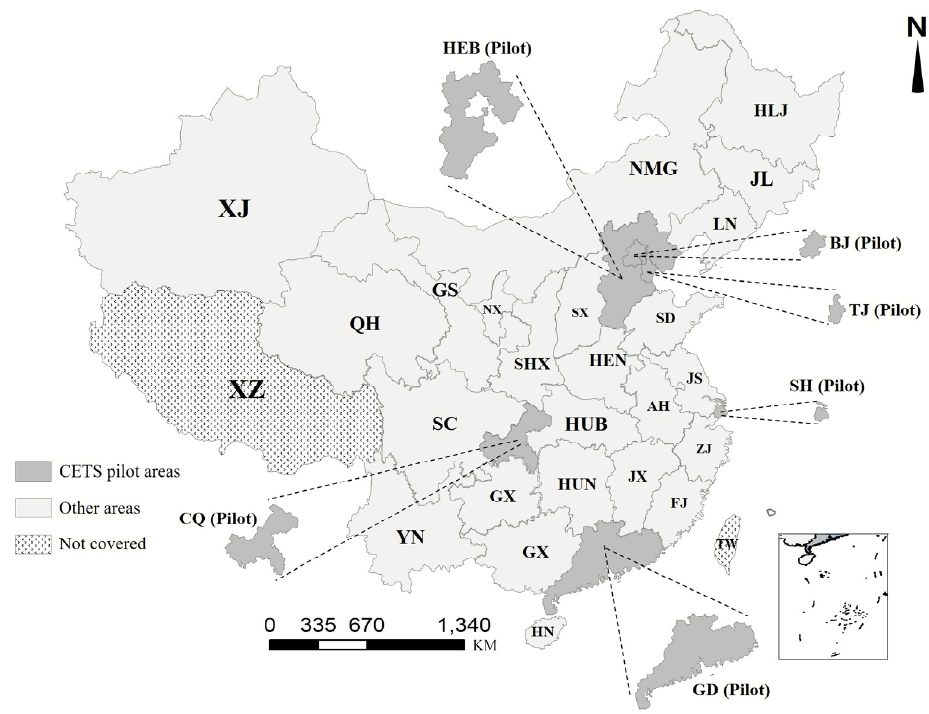
Figure 2. Distribution map of the six pilot regions.